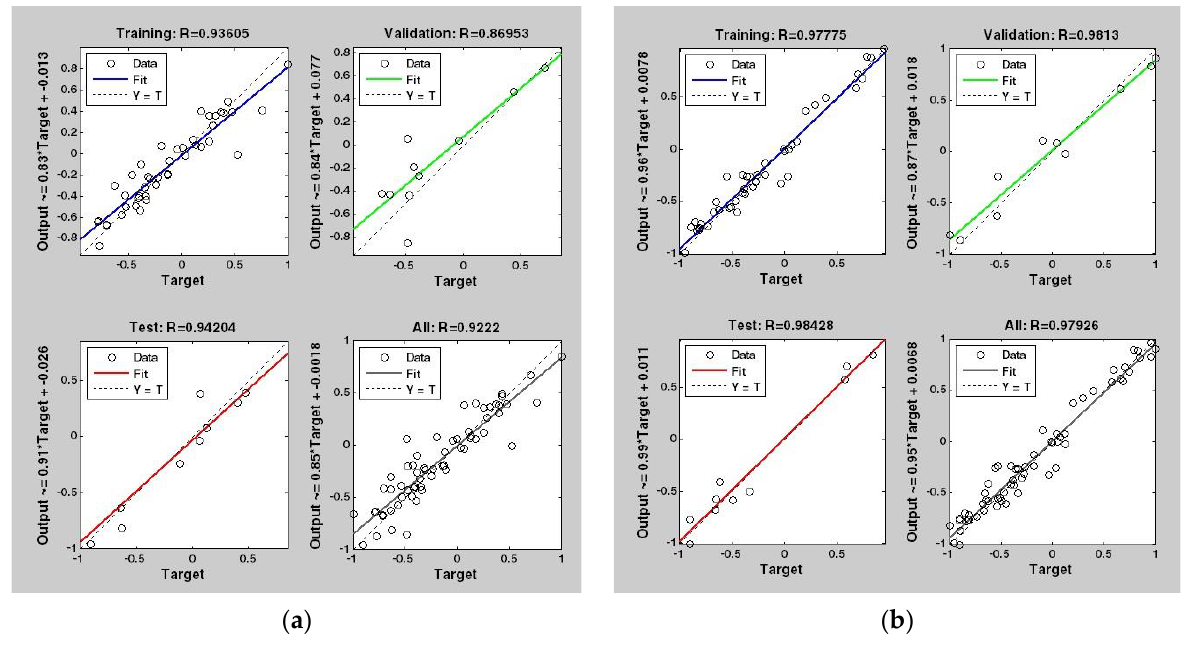
Figure 6. Correlation coefficients of EM ( a ) and UCS ( b ) prediction using optimum BPNN.